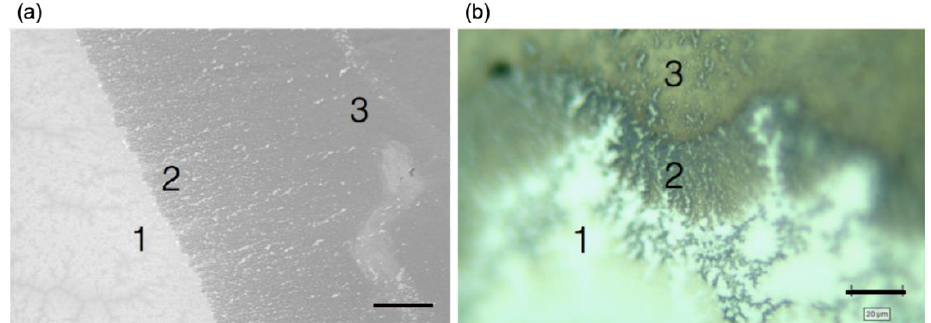
Figure 4. ( a ) and ( b ) represent SEM and optical images, respectively, of APCVD graphene on liquid In, using Ar flow rate of 1000 sccm. Both images show three regions where the graphene growth develops, (1) shows no deposition (2) the area of early deposition as a transition stage as dendritric graphene merges to initiate a more continuous graphene film in (3). The flow direction is in the direction of 1 to 3. (The SEM image was taken at low magnification in order to show the three regions with a scale bar of 100 μm, while the optical image scale bar is 20 μm).